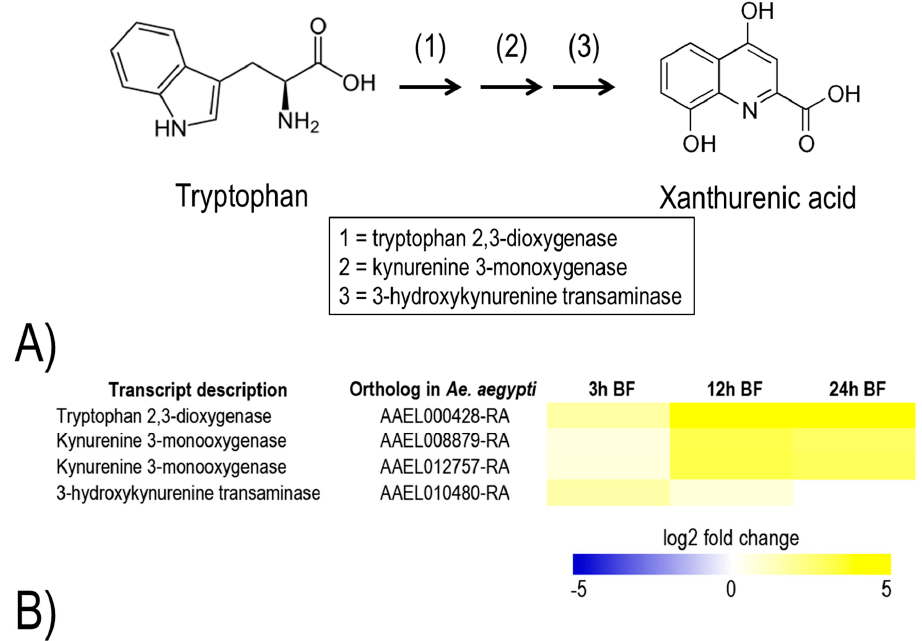
Figure 11. ( A ) Metabolic pathway for synthesis of xanthurenic acid from tryptophan. ( B ) Heat map of transcripts encoding enzymes associated with xanthurenic acid synthesis that are significantly up-regulated in the Malpighian tubules of blood fed (BF) adult female Ae. albopictus . The log2 fold changes in transcript expression are indicated by the provided color scale and are relative to Malpighian tubules of non-blood fed mosquitoes. Data are from [12].